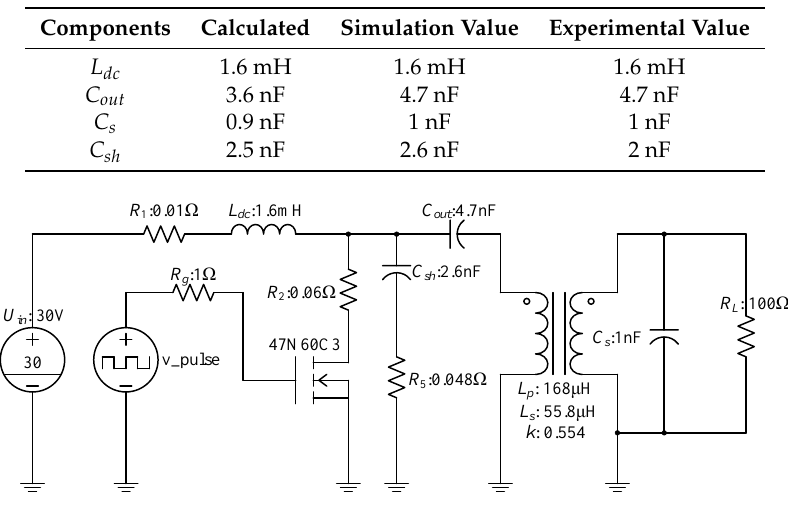
Figure 7. Simulation model of WPT based on a class E